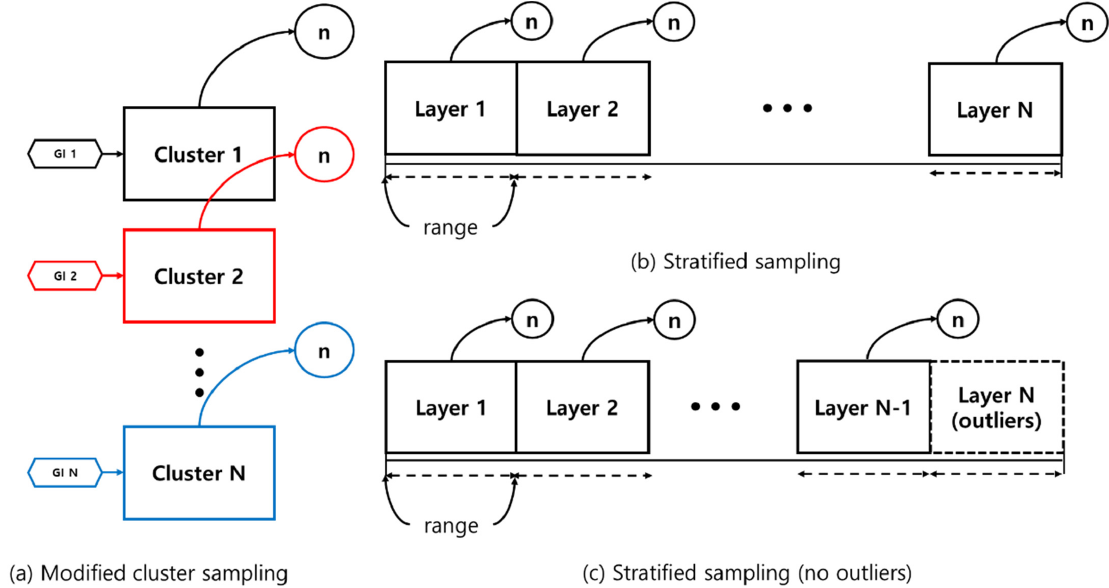
Figure 3. Schematic diagram of the three sampling methods. ( a ) Modified cluster sampling ( b ) Stratified sampling ( c ) Stratified sampling (no outliers).